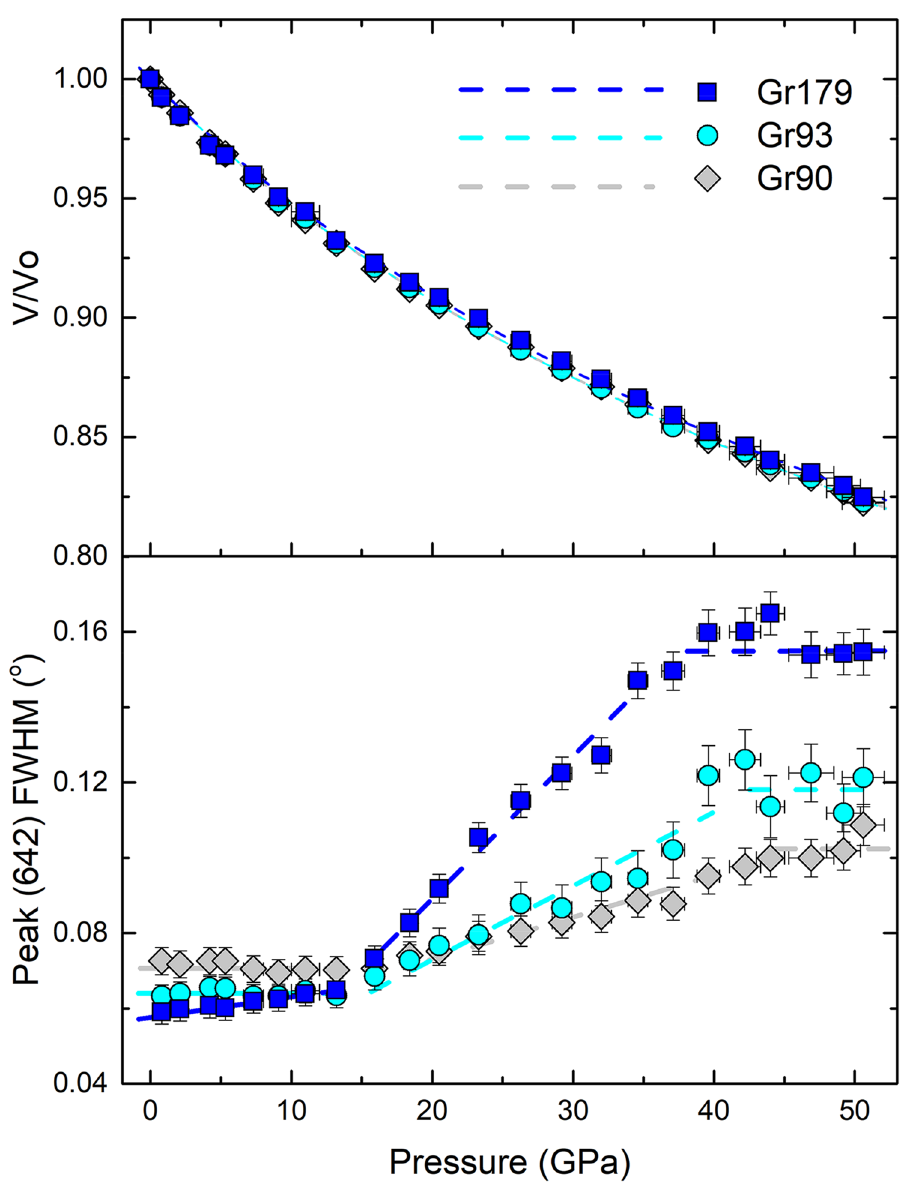
Figure 4. Normalized Pressure–Volume plot of ultrafine micro/nanocrystalline grossular up to 50 GPa. The FWHM of the diffraction peak (642) are shown in the